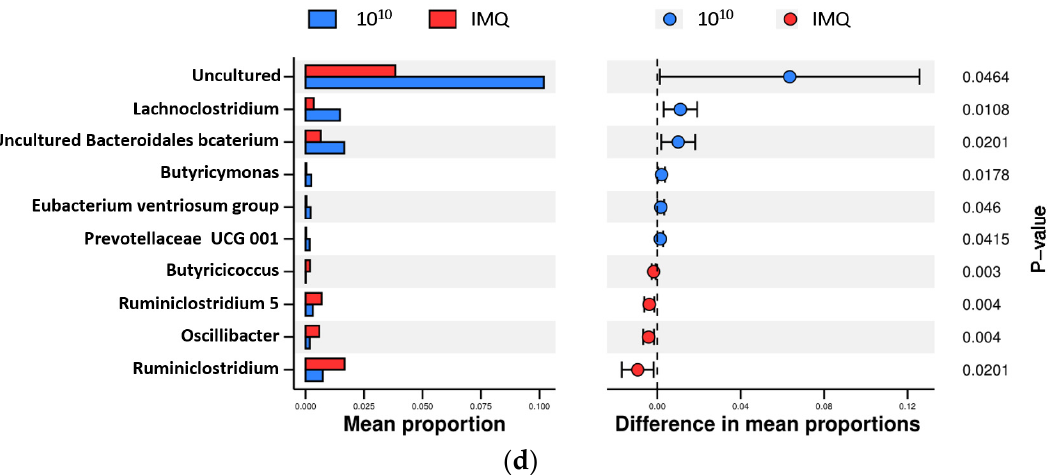
Figure 10. Effect of CCFM683 treatment on the gut microbial composition in IMQ-treated mice. ( a ) Phylum level of gut microbiota. Genus level of microbiota in control vs. IMQ ( b ), 10 9 CFU/day CCFM683 vs. IMQ ( c ), and 10 10 CFU/day CCFM683 vs. IMQ groups ( d ) were compared.